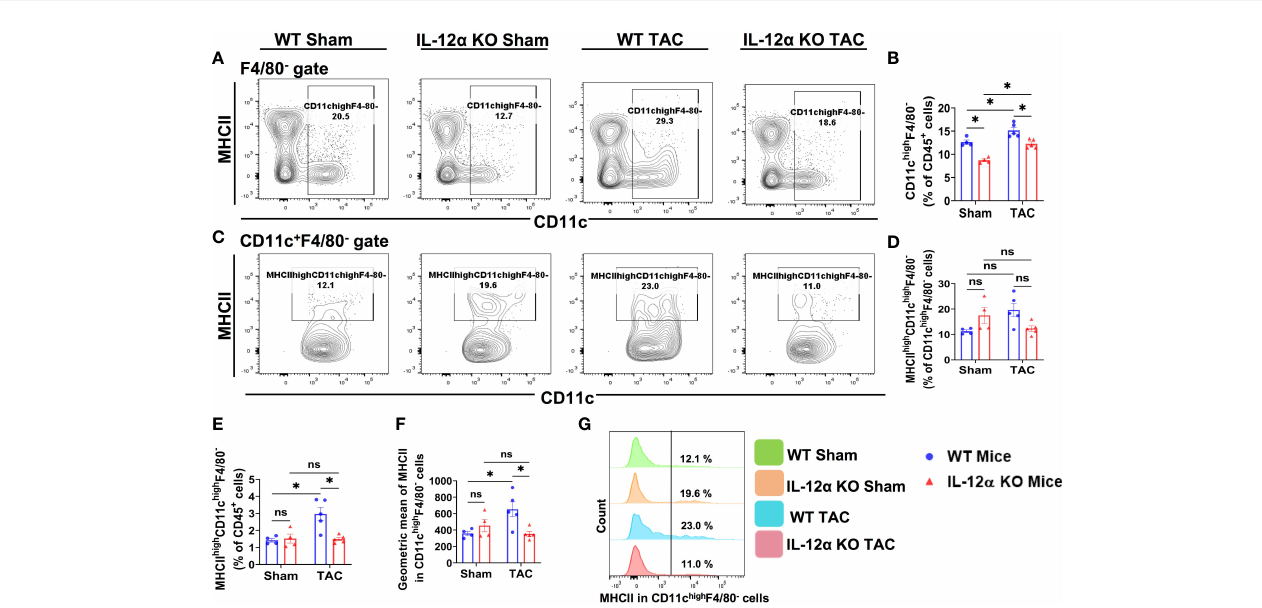
FIGURE 4 IL-12 a KO signi fi cantly attenuated TAC-induced lung dendritic cell (CD11c high F4/80 - ) accumulation and activation. (A) Flow cytometry plots for CD11c high F4/80 - cells in the lung. (B) Percentage of CD11c high F4/80 - cells within CD45 + leukocytes. (C) Flow cytometry plots for the identi fi cation of MHCII high CD11c high F4/80 - dendritic cells. (D, E) Quanti fi ed percentage of MHCII high CD11c high F4/80 - dendritic cells within CD11c high F4/80 - or CD45 + leukocytes. (F) Mean fl uorescent intensity of MHCII in CD11c high F4/80 - cells. (G) Representative histograms showing MHCII expression in CD11c high F4/ 80 - cells. *p<0.05, ns, non-signi fi cant.